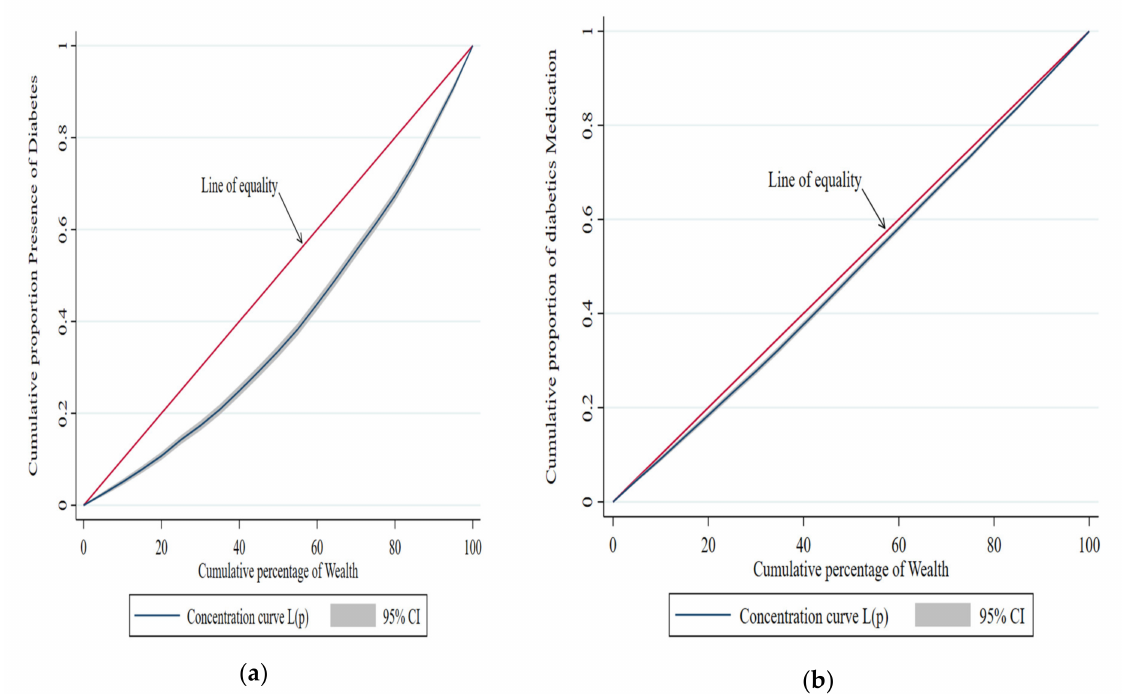
Figure 4. Concentration curve for the cumulative proportion of the presence of diabetes and the use of diabetes medicines, versus the cumulative percent of wealth, India (LASI). ( a ) Description of the cumulative proportion of presence of diabetes in the first panel; ( b ) Description of the cumulative proportion of presence of diabetes medicine use in the second